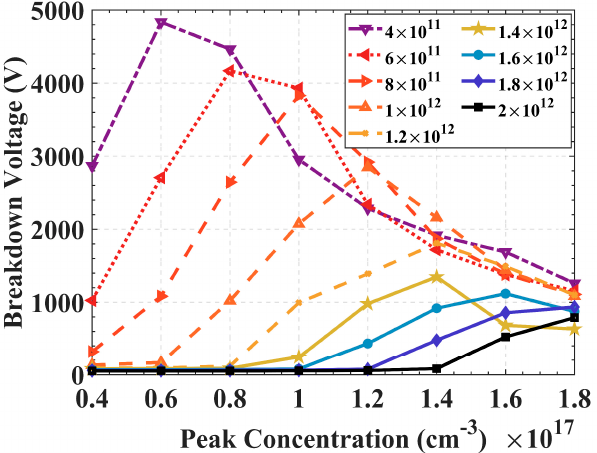
Figure 8. Relationship between peak concentration of floating ring and breakdown voltage at different oxide charge densities.